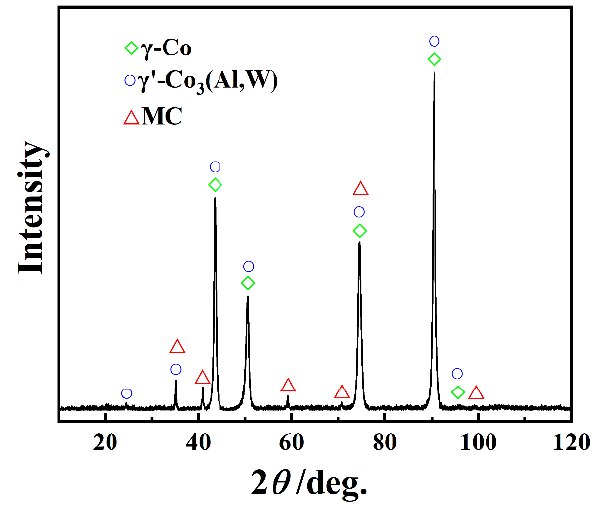
Figure 1. XRD pattern of the Co–Al–W–base superalloy that consisted of γ –the matrix, γ ’–L1 2 ordered strengthened phase, and MC-type carbide.